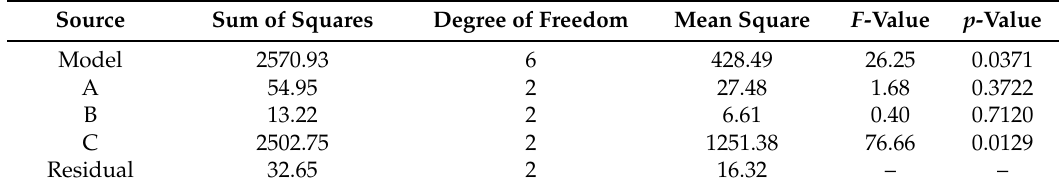
Table 7. ANOVA analysis results for photocatalytic degradation of chloroxylenol 1 . Source Sum of Squares Degree of Freedom Mean Square F -Value p -Value Model